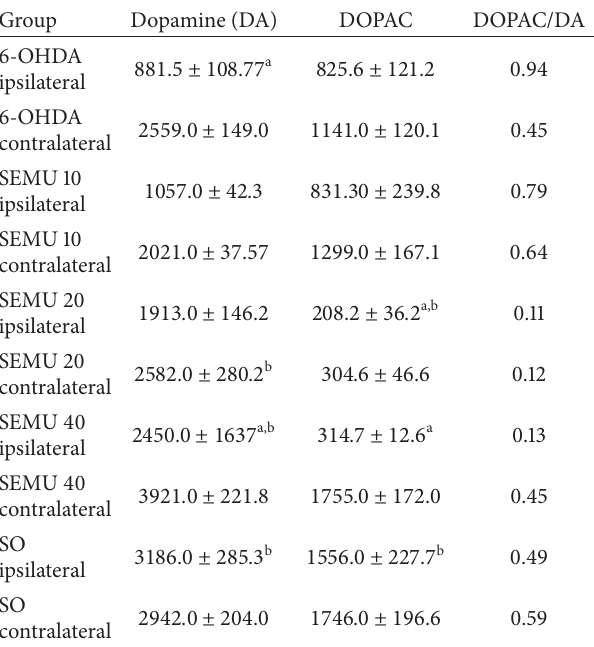
Table 2: Effects of the standardized extract from M . urundeuva (SEMU)onstriatalDAandDOPAClevels(ng/gtissue),inthemodel of Parkinson’s disease in